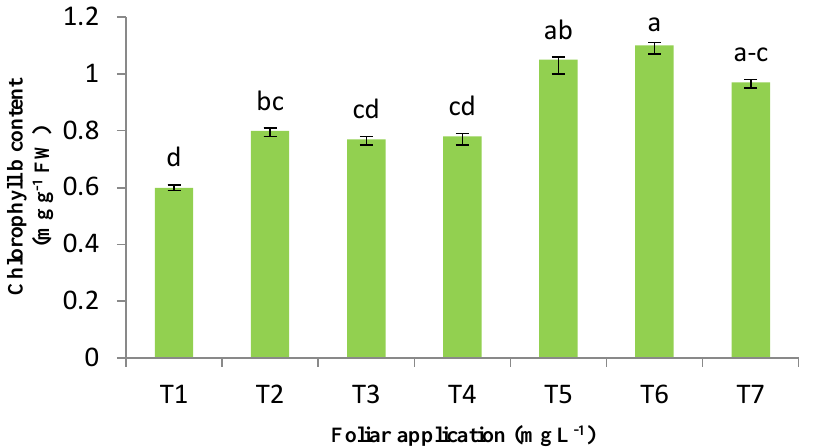
Figure 5. Effects of foliar treatments on chlorophyll b content of Aloe vera . Different letters on bars indicate significant differences among foliar treatments at p < 0.05 by LSD test. T1: control, T2: Magnetic Fe nanoparticle, T3: Zn nanoparticle, T4: KNO 3 , T5: Fe + Zn nanoparticles, T6: Fe nanoparticle + KNO 3 , T7: Zn nanoparticle+ KNO 3 .